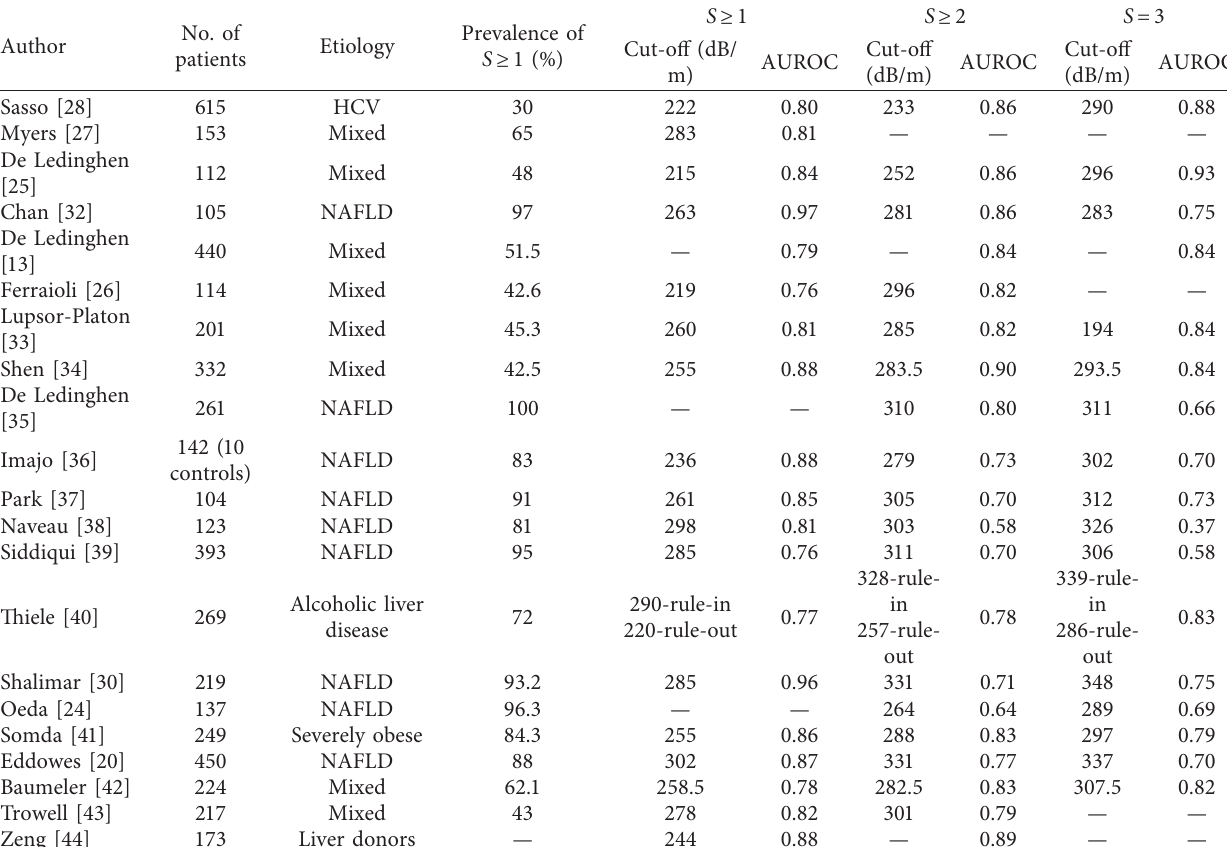
Table 1: Performance of CAP (M probe) to diagnose steatosis in patients with CLD, with liver biopsy as the reference method.